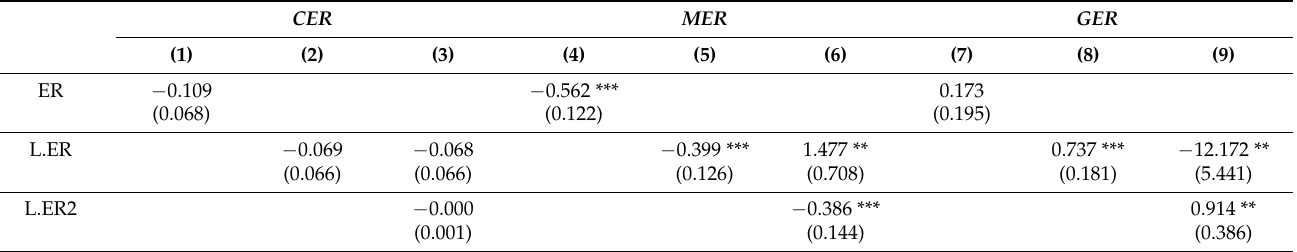
Table 4. Impact of environmental regulation on citrus